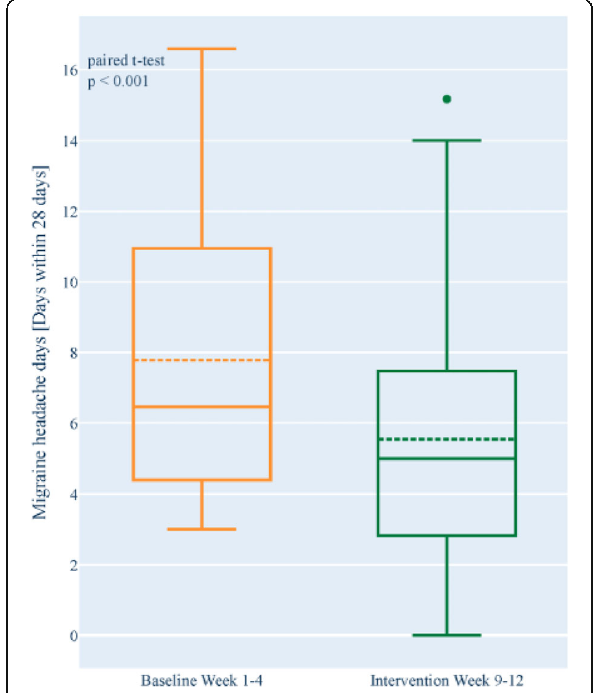
Fig. 1 (abstract P176). Change in the number of monthly migraine headache days between the four-week baseline phase and the last four weeks of the intervention phase in the complete data set analysis (n=62). Number of headache days was assessed by daily headache diary. Boxplots show 1st quartile, median (solid line), mean (dashed line), and 3rd quartile. Outliers are marked with